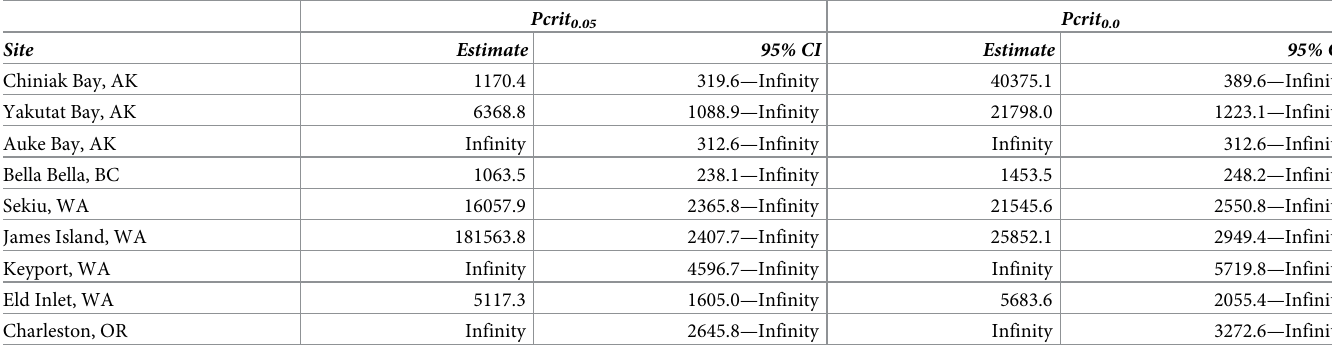
Table 5. Linkage desquilibrium N e estimates with 95% confidence